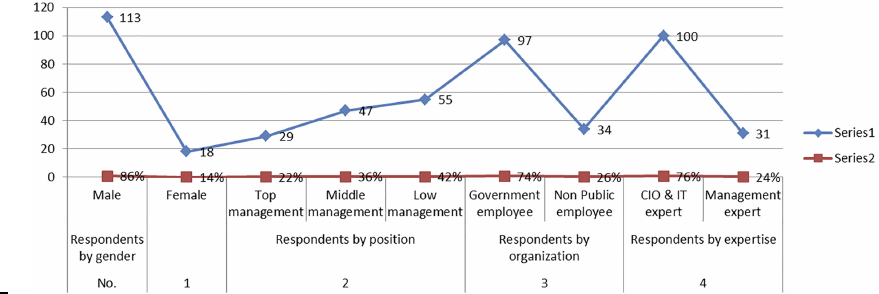
Figure 5. The categorization